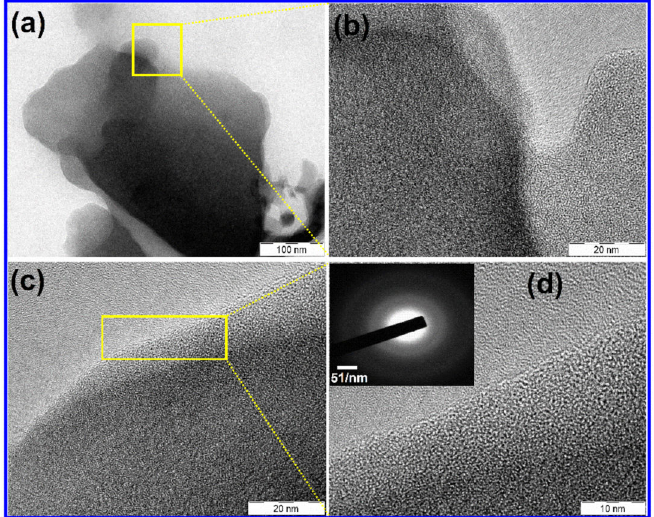
Figure 3. TEM images of ( a – d )